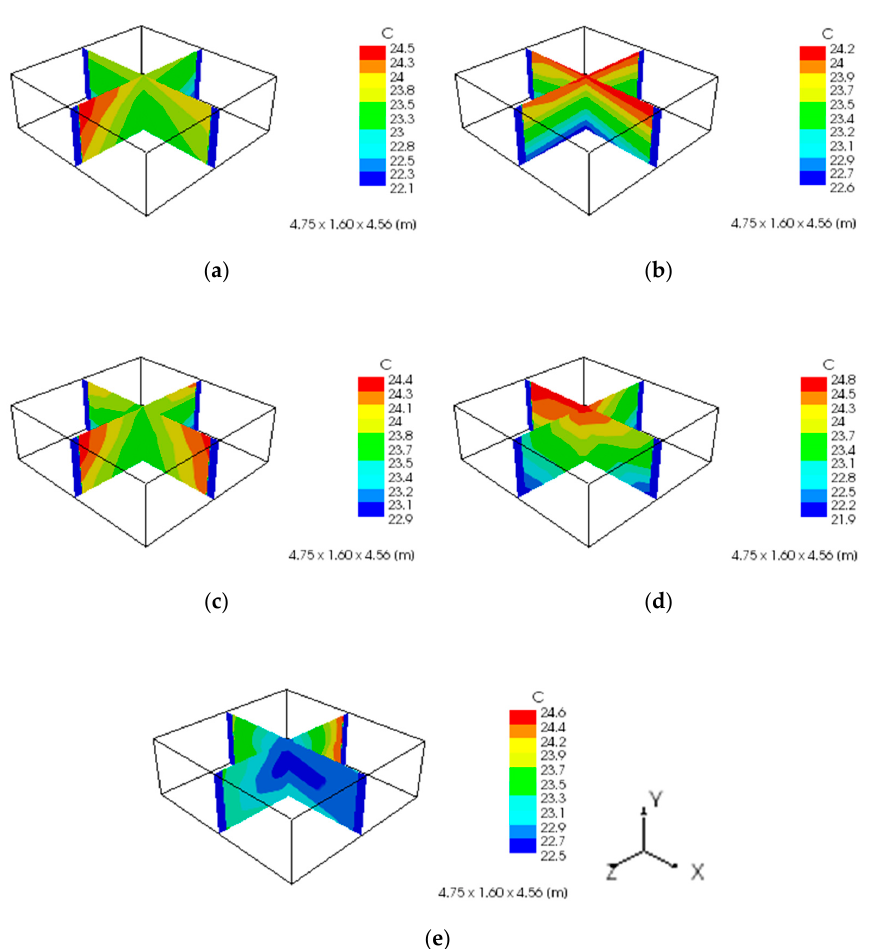
Figure 9. Air temperature profiles in the experimental laboratory for individual variants; ( a ) Variant 1; ( b ) Variant 2; ( c ) Variant 3; ( d ) Variant 4; ( e ) Variant 5.